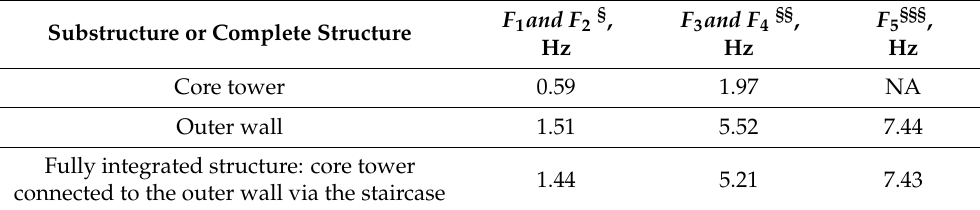
Table 5. Resonant frequencies of the minaret and its substructures.